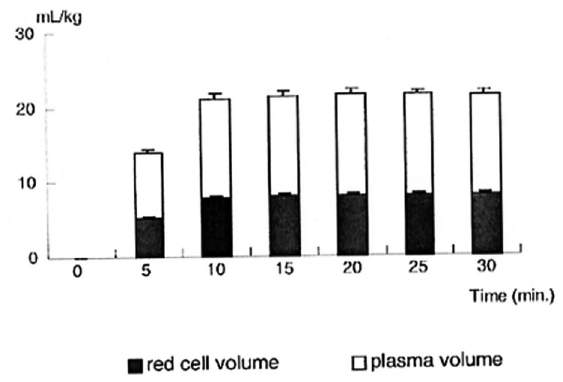
Figure 4 – Volume of the retroperitoneal hematoma (VRPH) and volume of red cells in the hematoma (VRCH) at five-minute intervals in Experiment C (no fluid resuscitation). Bleeding was more pronounced during the initial 15 minutes after the bilateral iliac artery injuries were created